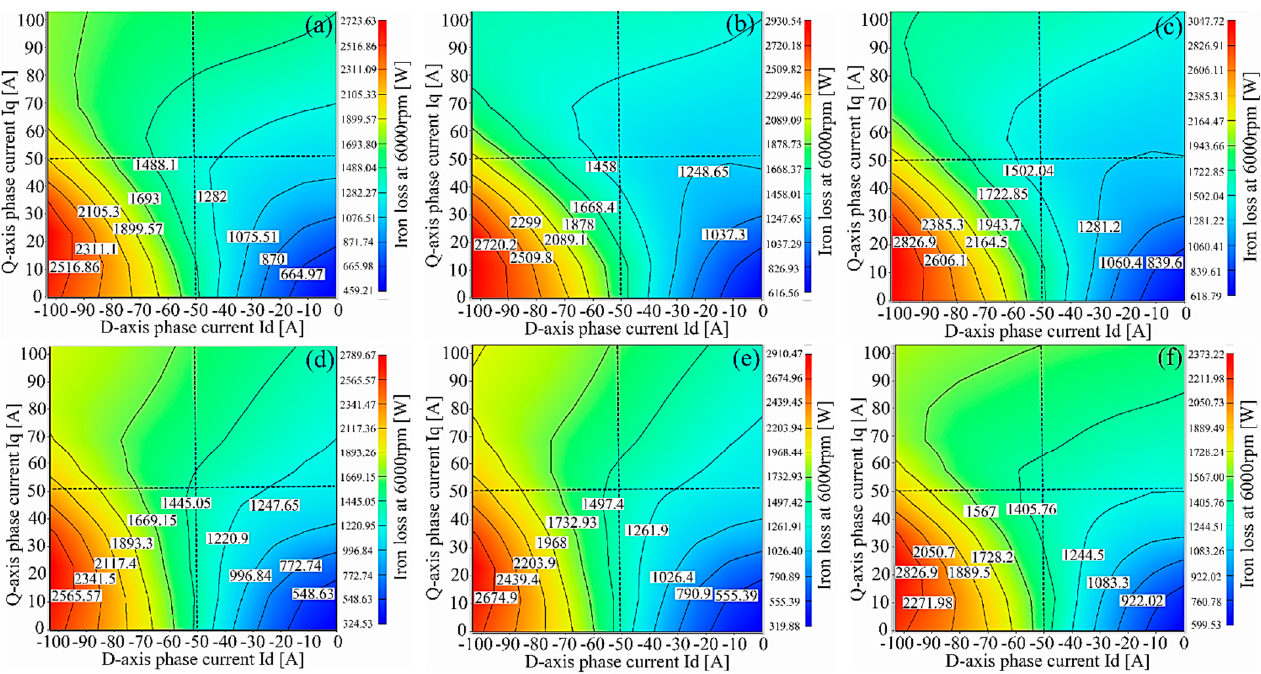
Figure 5. Iron loss maps at 6000 rpm for the IPMSM with ( a ) R-ROW, ( b ) R-SOW, ( c ) R-IOW, ( d ) RCL-SOW, ( e ) RCL-IOW, and ( f ) H-NOW arrangements.